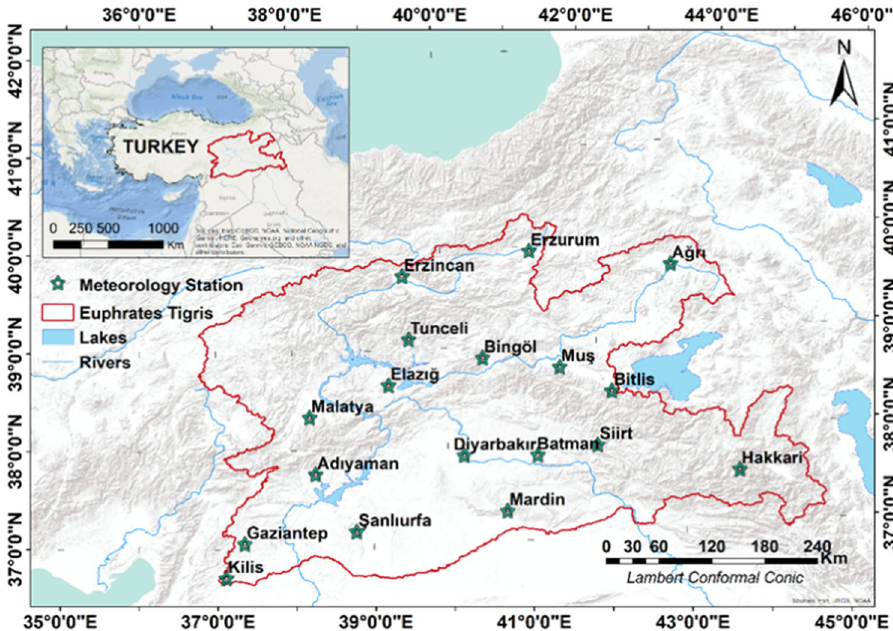
Fig. 2 Locations of precipita- tion measurement station in